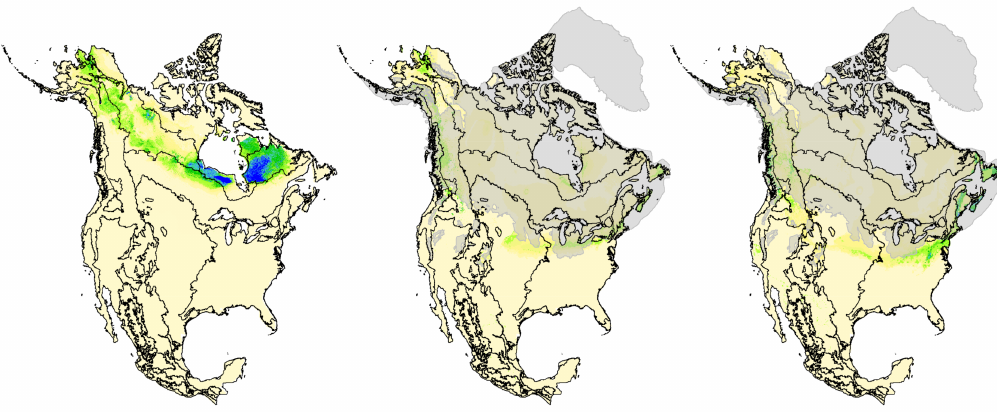
Figure 7. Predictions of current breeding density ( left ) versus hindcasted paleo-breeding densities of rusty blackbirds (based on [53]. Paleo-breeding densities were hindcasted by fitting models of current rusty blackbird density with bioclimatic indices downscaled by Roberts and Hamann [92] for the last glacial maximum (21,000 YBP) using two global climate models: Community Climate Model (CCM1, middle ) and Geophysical Fluid Dynamics Laboratory (GFDL, right ). Model-predicted density values range from 0 to 1.4 pairs/ha. Overlaid on hindcast projections are level 1 ecoregion boundaries in black [94] and the extent of Last Glacial Maximum (LGM) ice sheets in transparent gray